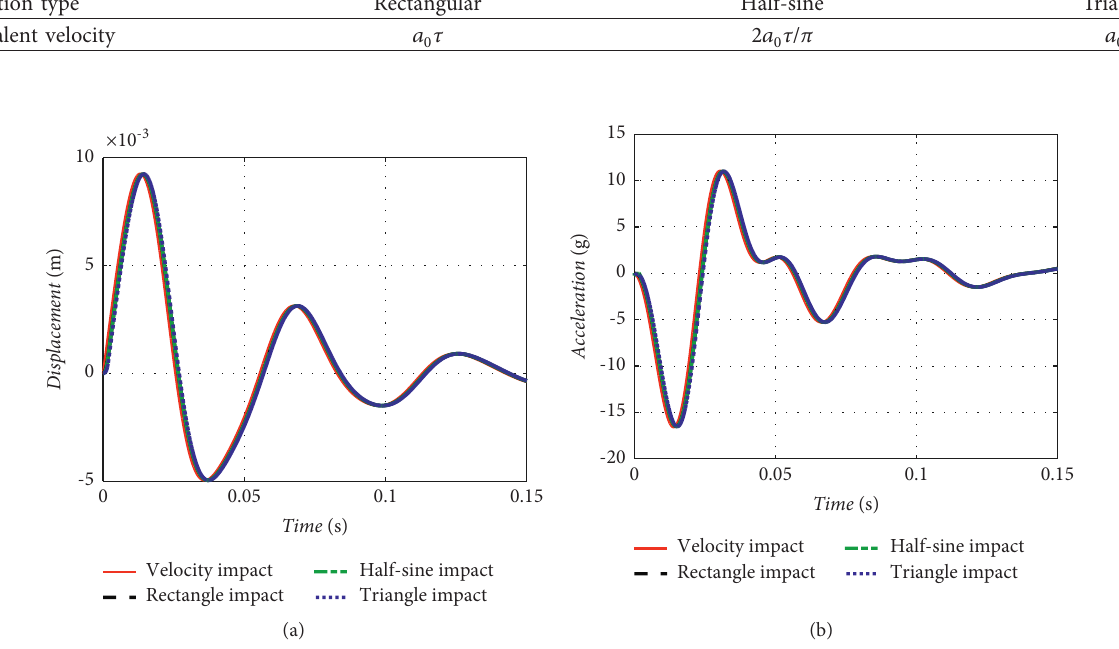
Figure 8: Response of a packaging system with cubic stiffness under different excitations at a duration of 2ms. (a) Displacement. (b) Acceleration.